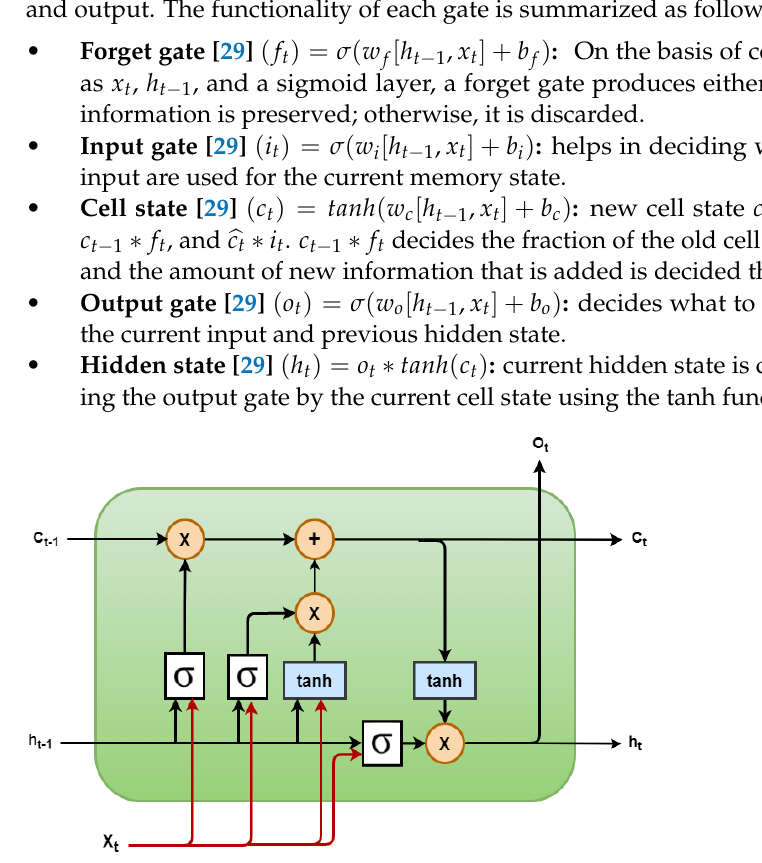
Figure 3. Schematic diagram of an LSTM